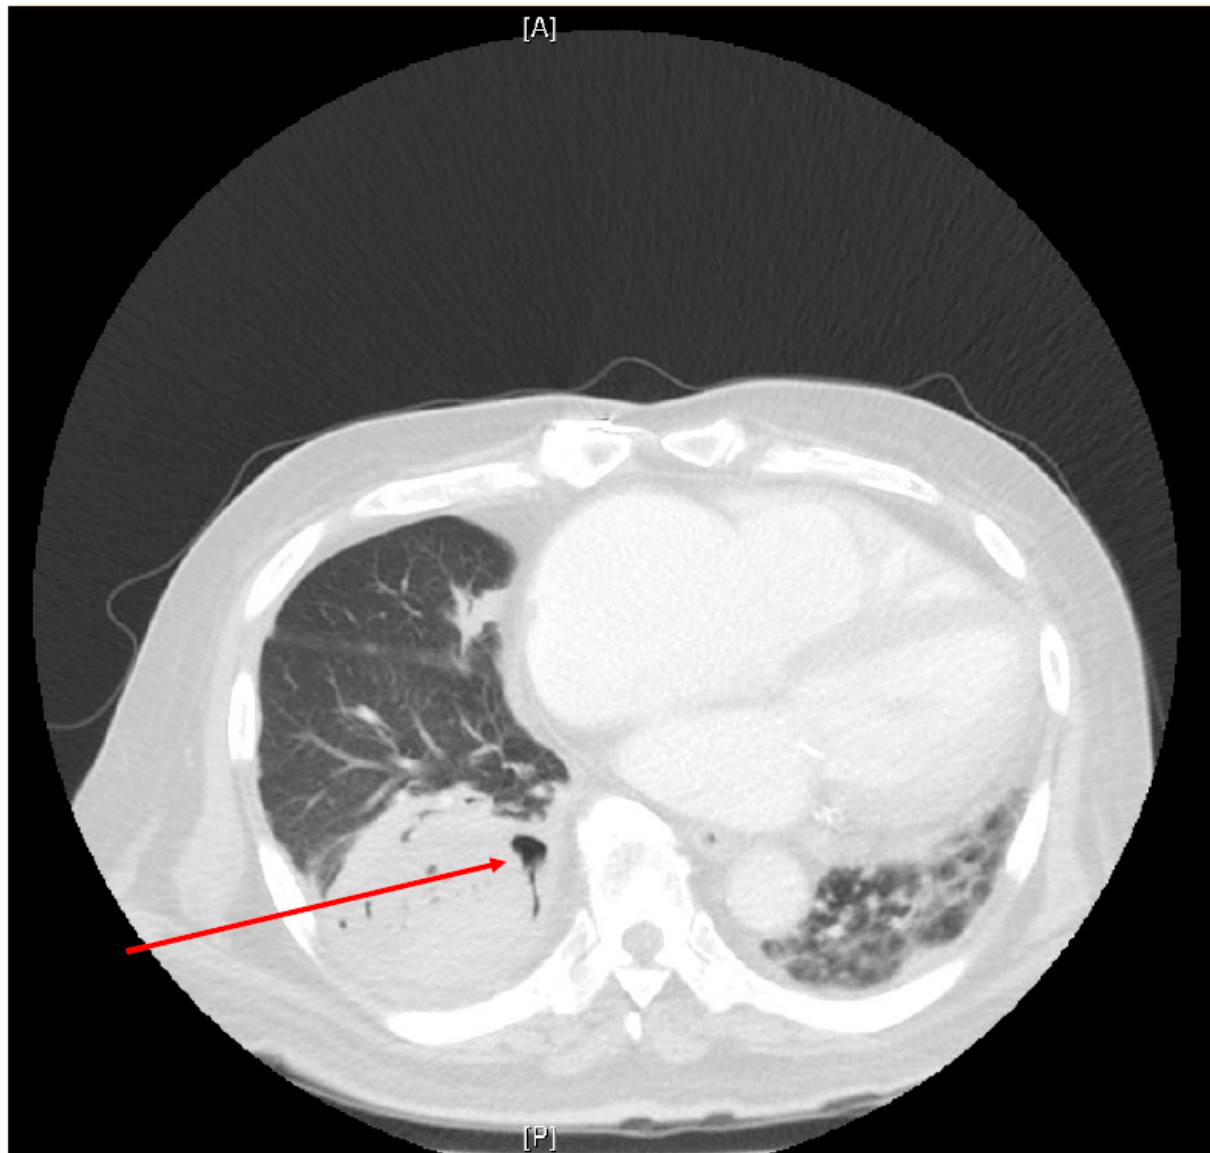
Figure 1. Chest Computer Tomography (CT) scan of a patient who had recovered from COVID-19 two months prior to presenting with new onset right-sided lower chest pain. Abnormalities on CT scan include a large mass lesion in the postero-basal segment of the right lower lobe with the beginnings of possible cavitation (arrow). A pleural effusion is present at the right lung base. The left lung shows consolidation with ground glass opacities. Fine needle aspiration of the right lower lobe mass yielded Rhizopus microsporus on culture with broad, pauci-septate irregular fungal hyphae seen on standard histopathological stains. [A]—anterior; [P]—posterior.